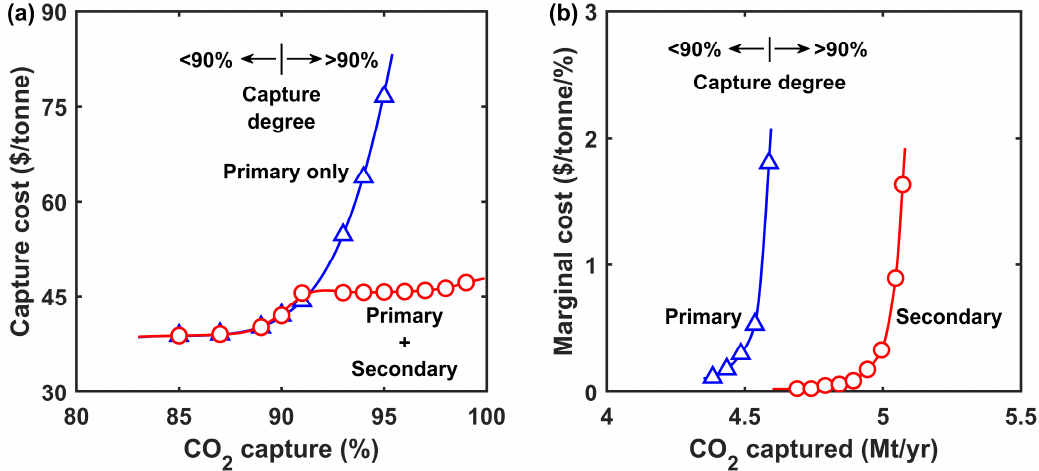
Figure 7. ( a ) Capture costs at different CO 2 capture degrees for the primary system only and the combined primary and secondary systems in tandem. ( b ) Marginal costs of the combined systems.